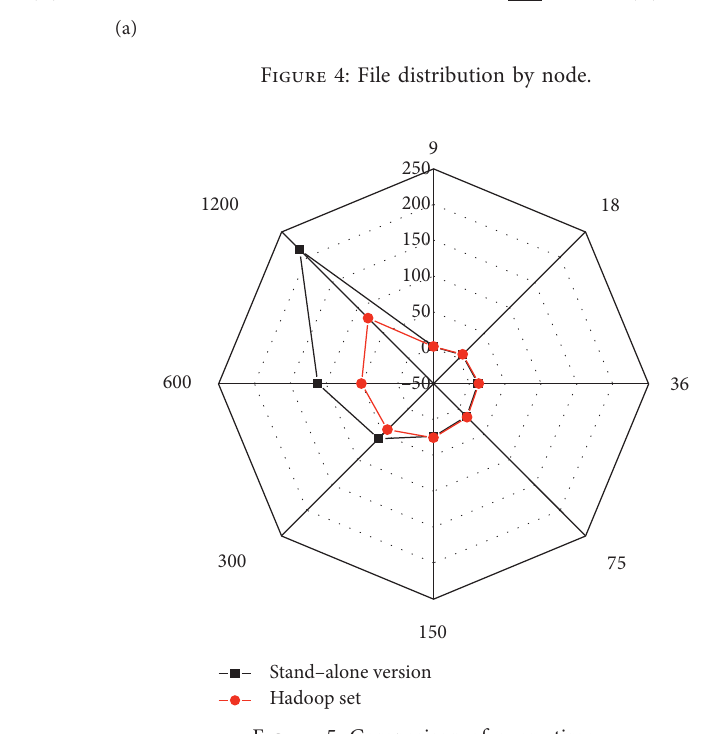
Figure 5: Comparison of query time.